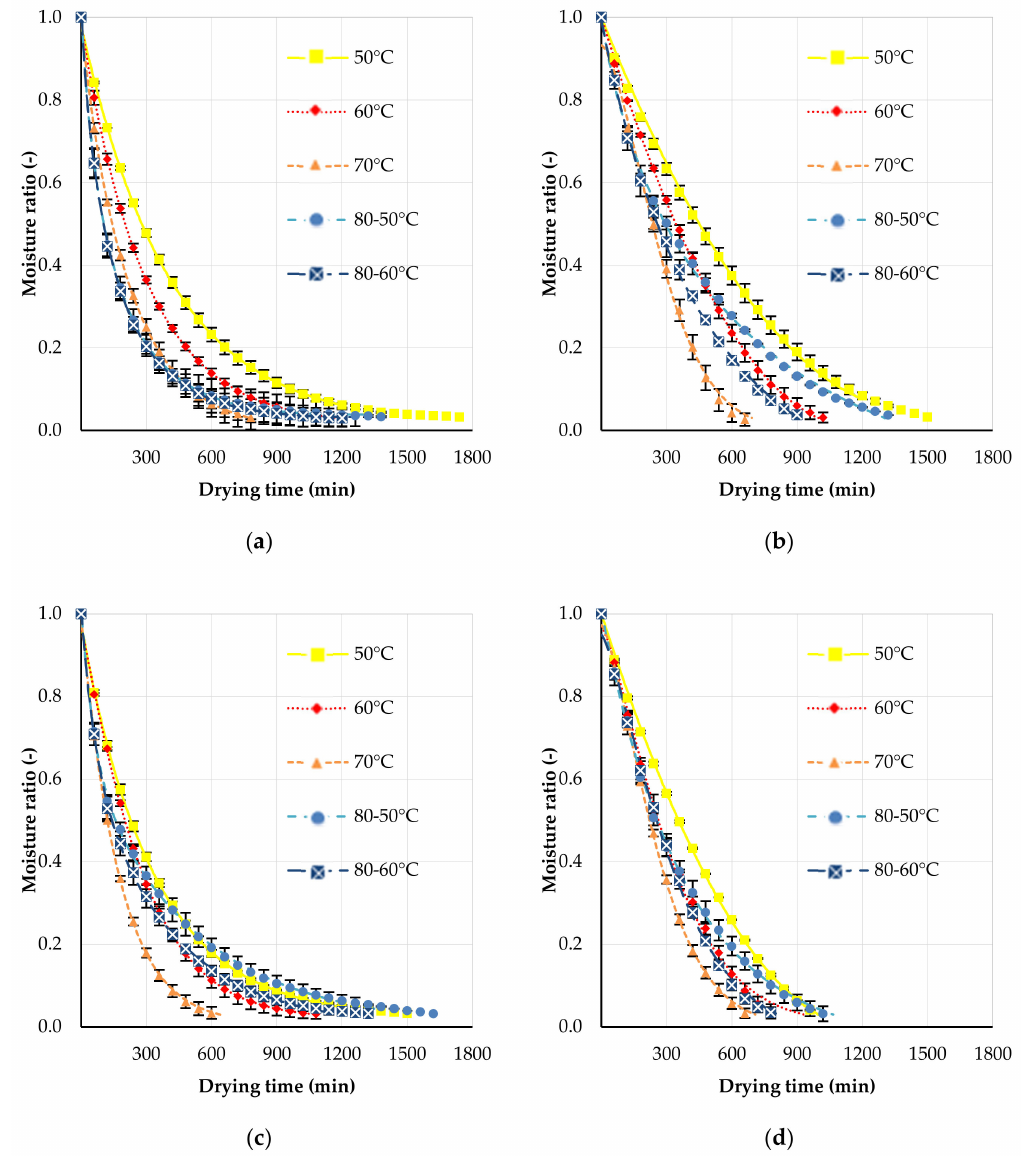
Figure1. Moistureratio(MR)kineticsofdried( a )Genevausingtheconvectivemethod, ( b )Genevausing the vacuum method, ( c ) Weiki using the convective method, and ( d ) Weiki using the vacuum